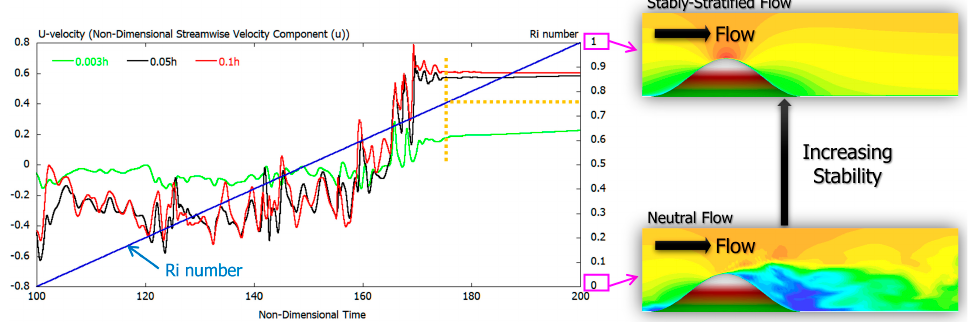
Figure A1. Time variation of U-velocity at three measurement points downstream of the steep hill.